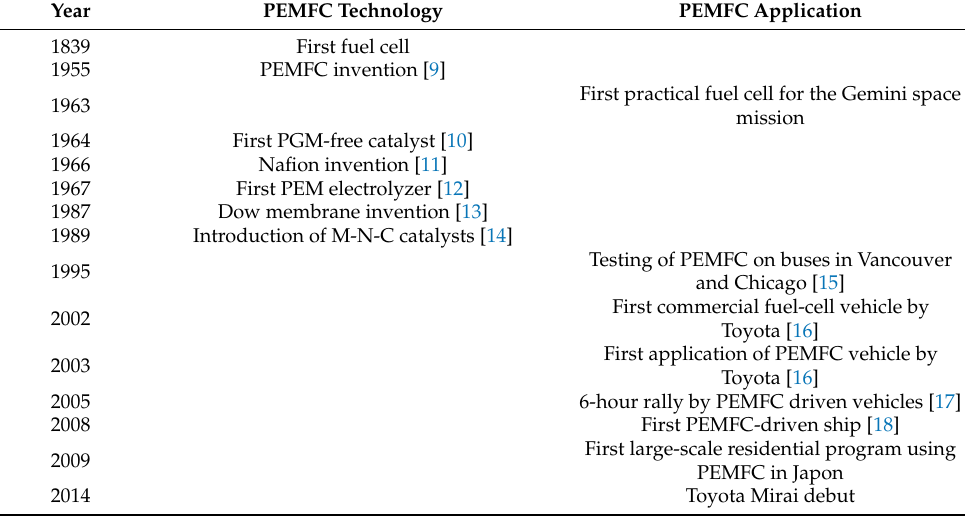
Table 1. Major milestones in PEMFC degradation and deployment.